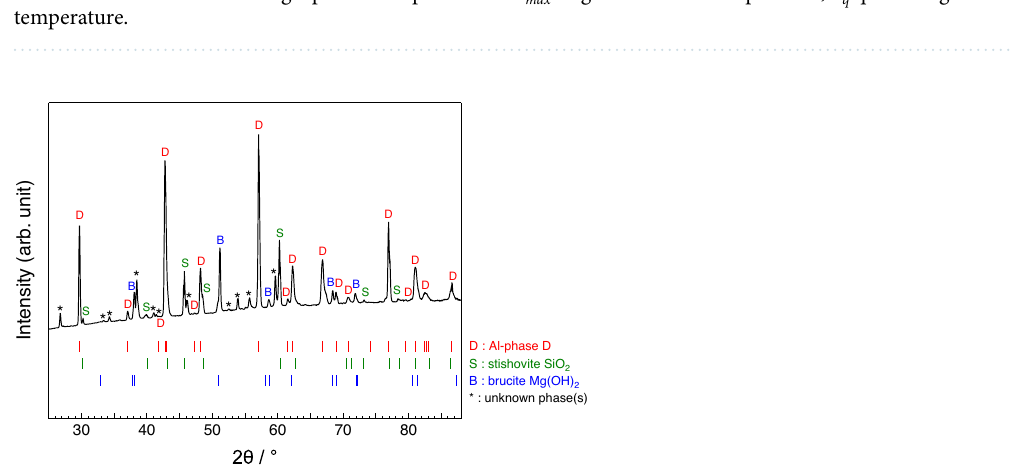
2 –Al 2 O 3 , with Al content close to that reported for bridgmanite formed from a representative mantle composition, under over-saturation of water. We reveal the incorporation mechanism of Al and a large amount of hydrogen (H) into phase D and demonstrate the drastic enhancement in stability of phase D due to the incorporation of a relatively small amount of Al. We discuss the mechanism for such a high stability of Al- phase D, in terms of crystal chemistry based on single-crystal X-ray diffraction. On the basis of these findings, we propose crucial implications for the recycle of water in the lower mantle. We selected the starting composition of 0.92MgSiO 3 ·0.08Al 2 O 3 because it is close to the composition of bridg- manite, 0.94MgSiO Table 1. Reagent grade oxides and hydroxides were mixed in the required ratios and sealed in platinum (Pt) capsules together with amounts of liquid water suitable for over-saturation. The samples were compressed to 27 GPa (runs #1 and #2) or 26 GPa (run #3) and then heated to each target maximum temperature of 1600 °C (run #1) or 1900 °C (runs #2 and #3) using a Kawai-type multi-anvil apparatus 22 . After undergoing each thermal history, the samples were quenched at 1600 °C (runs #1 and #2) or 1300 °C (run #3) and recovered to ambient conditions. In all the runs, liquid water was seeping out of the Pt capsules when those were opened, which shows that the recovered samples were synthesized under over-saturation of water. We measured the microfocus X-ray diffraction patterns for the recovered samples of the runs #1 and #2. A typical example of them is shown in Fig. 1. In the patterns, we observed the diffraction peaks correspond- ing to phase D, stishovite SiO 2 and brucite Mg(OH) 2 . The peaks that cannot be assigned to any known-phases were also observed; these are probably due to impurities precipitated, together with brucite, from fluid during quenching. Here, we determined the unit-cell parameters with trigonal symmetry by least-squares fits of the d spacings of 21 peaks assigned to phase D as follows: a = 4.8239(1) Å, c = 4.3134(2) Å, V = 86.924(4) Å 3 for the run #1; a = 4.8416(1) Å, c = 4.3236(2) Å, V = 87.771(4) Å 3 for the run #2. The calculated d values of these peaks are in good agreement with the observed ones (Table 2). To confirm the presence of phase D, we conducted the electron probe microanalyses for the recovered sample of the run #1. The analytical result showed the presence of products with a chemical composition of 23.11 mass% MgO, 42.97 mass% SiO 2 and 18.66 mass% Al 2 O 3 with a total of 84.74 mass%. This phase was damaged by the